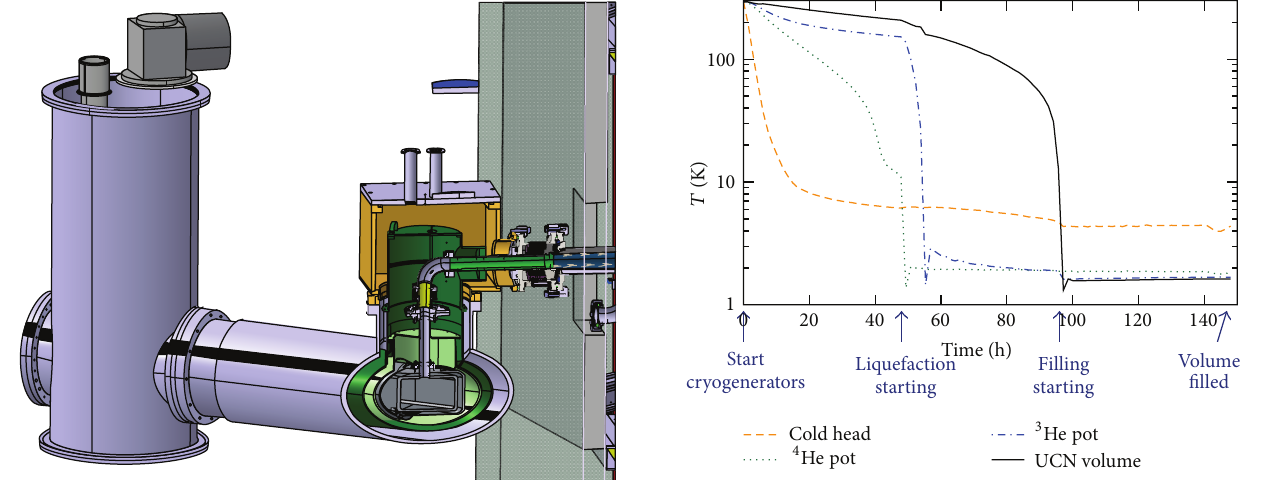
Figure 6: Extraction guides from the source to the spectrometer. The extraction guides are composed of several tubular elements, whicharethinfoilsofstainlesssteelinsertedinsidetubes.Thedesign oftheguidesallows compensating forthemisalignment between the source and the spectrometer.